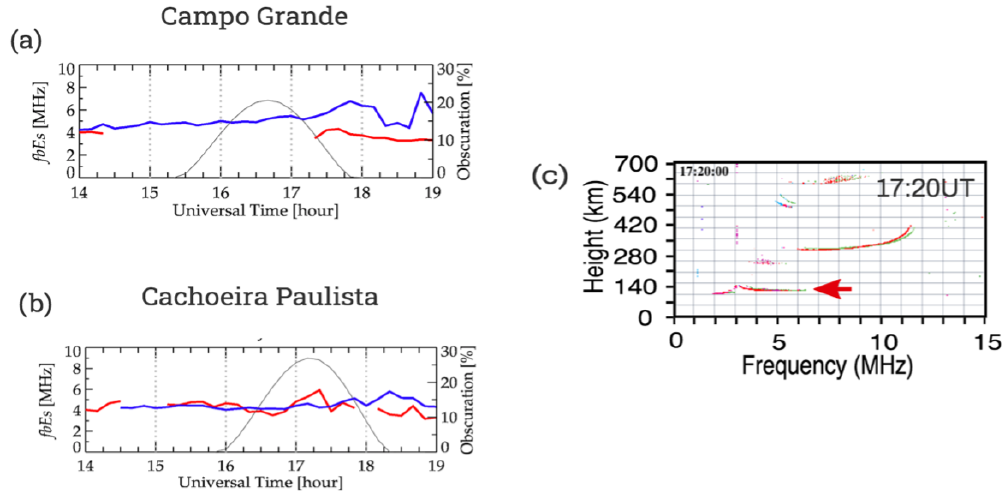
Figure 10. The blanketing frequency of the E s layer ( fb E s ) in (a) Campo Grande and (b) Cachoeira Paulista between 14:00 and 19:00UT, and (c) the ionogram for Cachoeira Paulista at 17:20UT. These parameters are presented by the blue line for the quietest day of the month (4 December 2020), and the red line refers to the solar eclipse on 14 December 2020. The grey line represents the solar eclipse obscuration for each